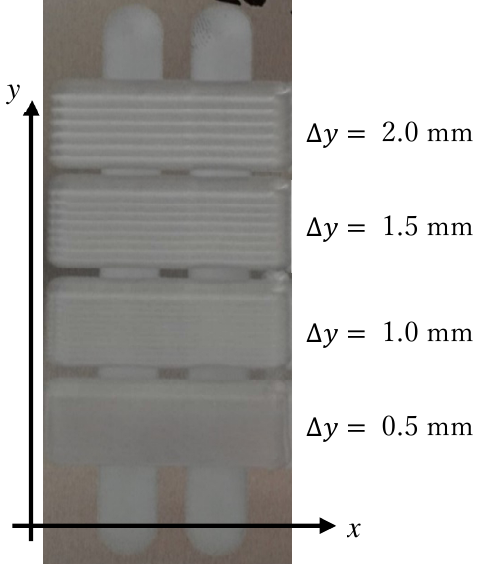
Figure 15. The photograph of the surface of the workpiece after processing.